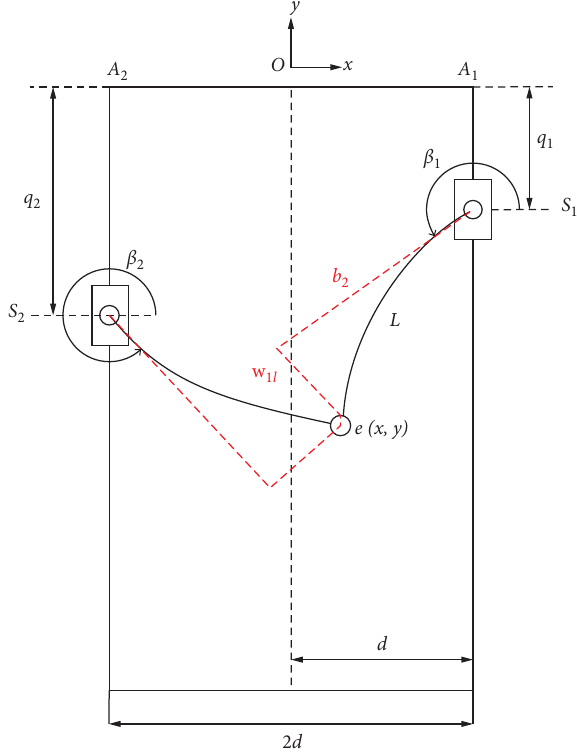
Figure 2: Coordinate system of 2-PRRRP with flexible